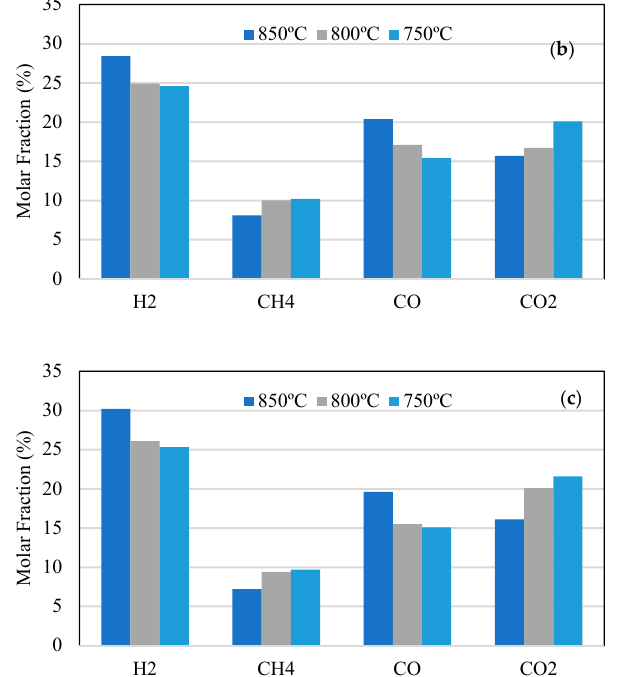
Figure 6. Effect of the temperature on the produced gas for S/B ratios of ( a ) 0.5, ( b ) 0.735, and ( c ) 1.0.